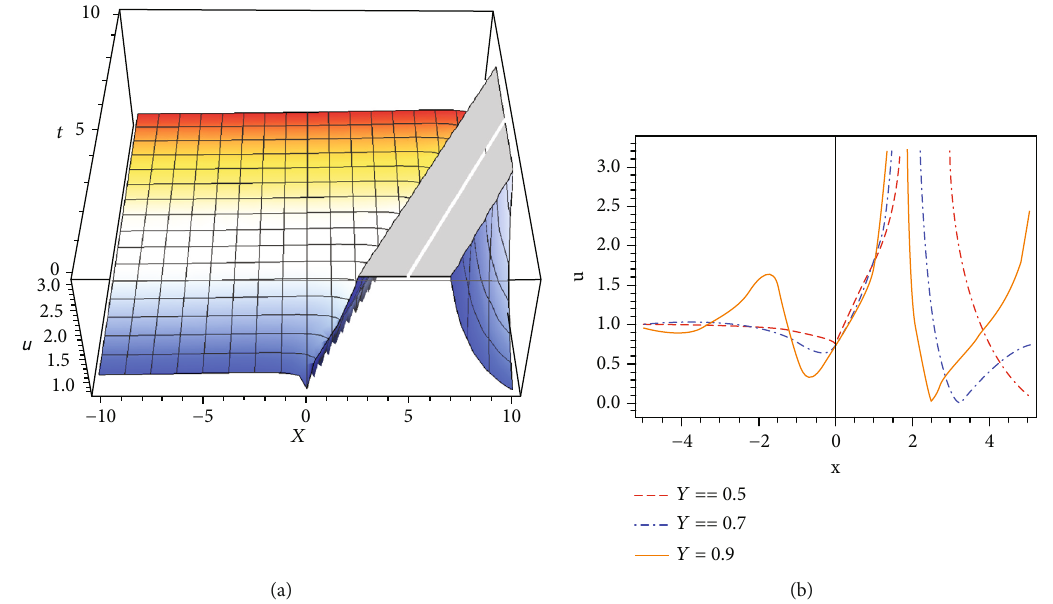
= 1 , T = 2 , V = 1 , c = 3 , a = 1 , b = 1 , and γ = 0 : 5,0 : 7,0 : 9 for the solution j u 1 ð x , t Þ with distinct values of γ . 8,1